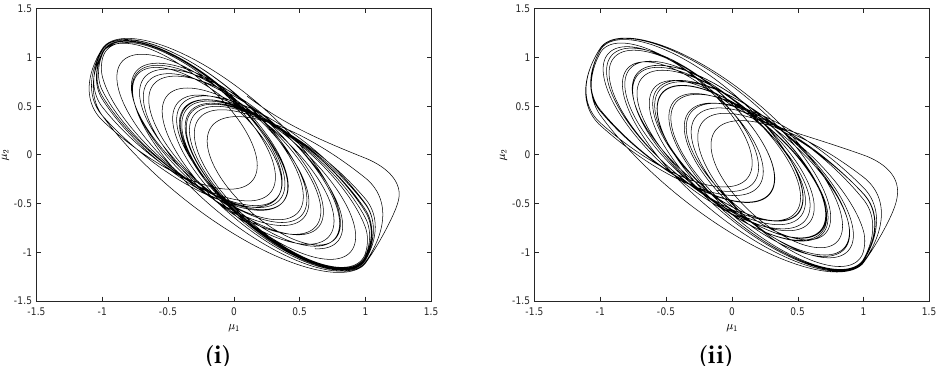
Figure 1. Phase diagram of the circuit system for a 1 = 1.00623, a 2 = 0.00894, b = 1.00621, c = 2.93595, f = 0.5272, and ω = 0.843; ( i ) µ 0 = ( 0.1,0.6 ) ; ( ii ) µ 0 = ( − 0.1,0.6 )